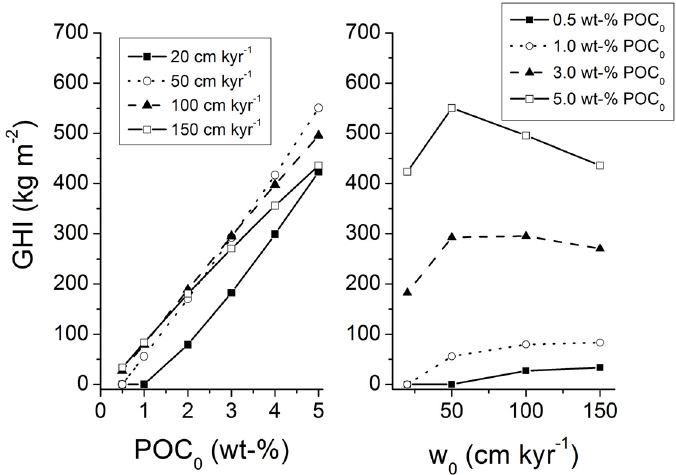
Figure 22. Effect of POC concentration and burial velocity on methane hydrate accumulation in continental margin sediments experiencing complete compaction ( Φ p = 1/1300 m − 1 ). See legend of Figure 16 for further